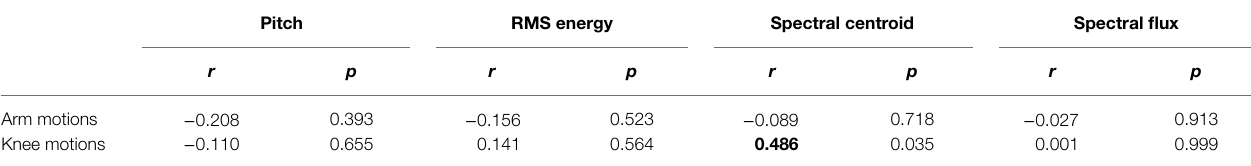
TABLE 1 | Correlation coefficients with significances between the variances in the motion areas and the acoustic parameters across all players (in bold: significant correlation p < 0.01).